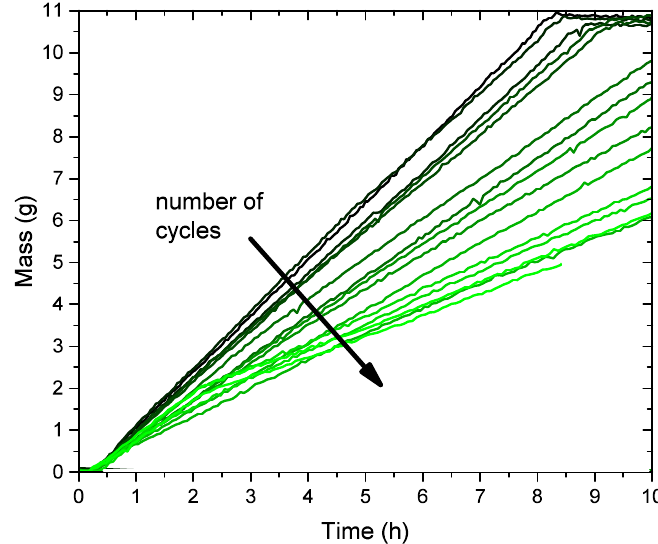
Figure 11. The mass of vessel 2 during condensation of water. The temperature of vessel 1 and 2 is 37 ◦ C and 35 ◦ C,